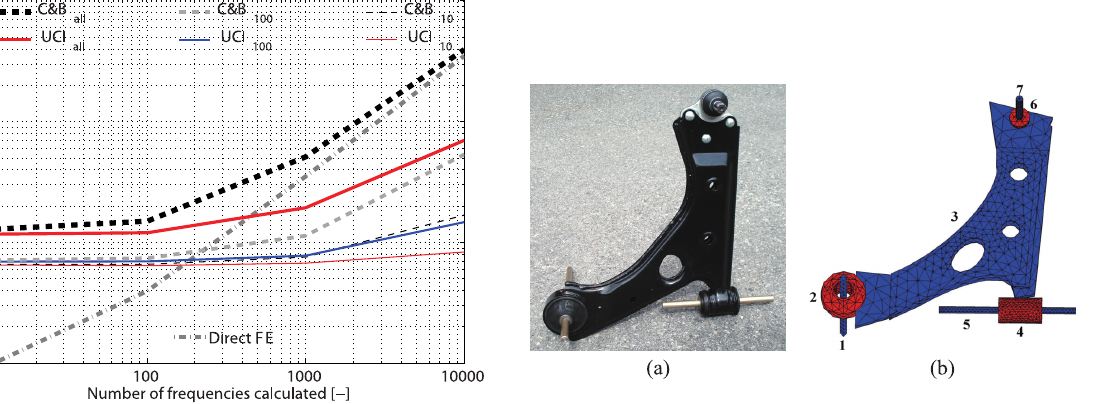
Fig. 11. Normalised time consumption as a function number of frequencies calculated. C&B method (dashed lines). UCI approach (solid lines) for different number of included inner modes (all, 100 and 10) and the direct solution (dashed-dotted line).